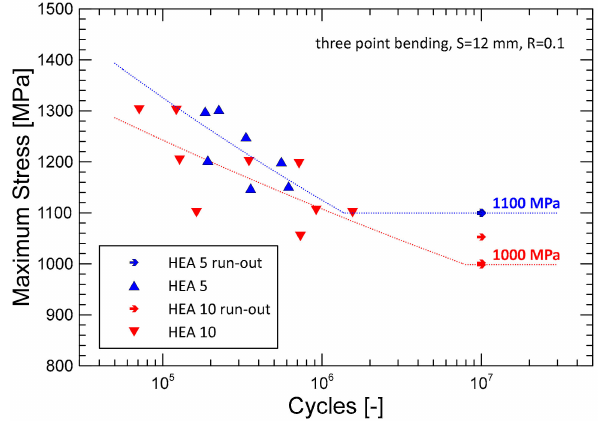
Figure 5. S-N curves of the experimental material